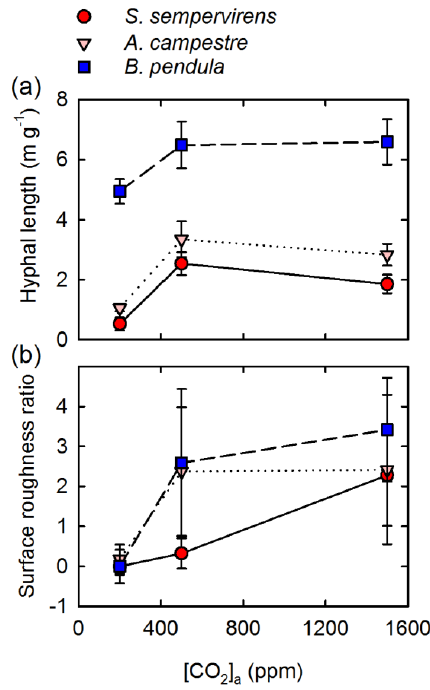
Fig. 1. [CO 2 ] a -regulated hyphal colonisation and mineral surface Figure 1. [CO 2 ] a -regulated hyphal colonisation and mineral surface alteration. (a) alteration. (a) Mycorrhizal hyphal lengths colonising basalt grains Mycorrhizal hyphal lengths colonising basalt grains and (b) muscovite roughness ratios (see and (b) muscovite roughness ratios (see Methods), decrease with Methods), decrease with falling [CO 2 ] a . All values are mean ± s.e.m. falling [CO 2 ] a . All values are mean ±